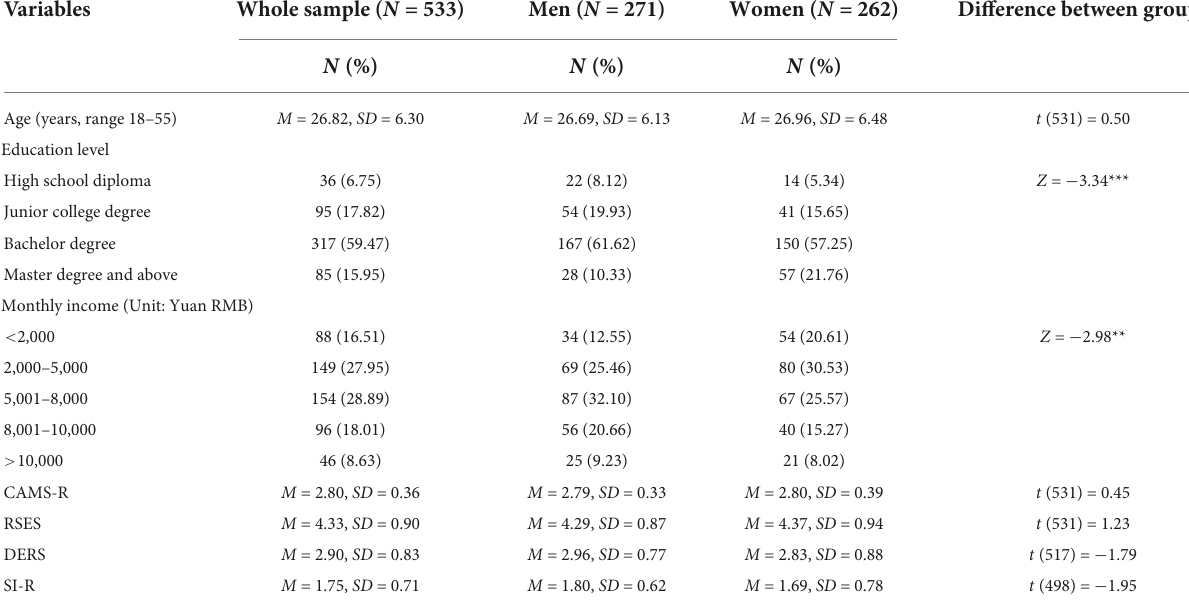
TABLE 2 Demographic information and results of the comparisons between